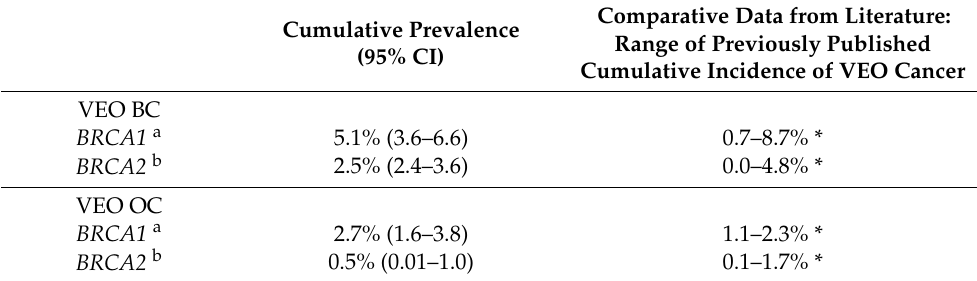
Table 1. Cumulative risk of very early-onset breast cancer (VEO-BC) and VEO ovarian cancer (VEO-OC) in BRCAm carrier women. Comparative Data from Literature: Cumulative Prevalence Range of Previously Published (95% CI) Cumulative Incidence of VEO